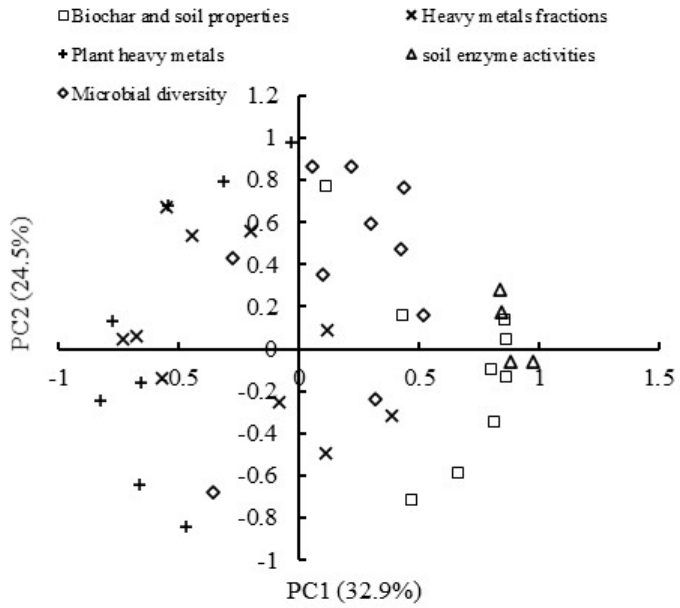
Figure 6. A principle component analysis.